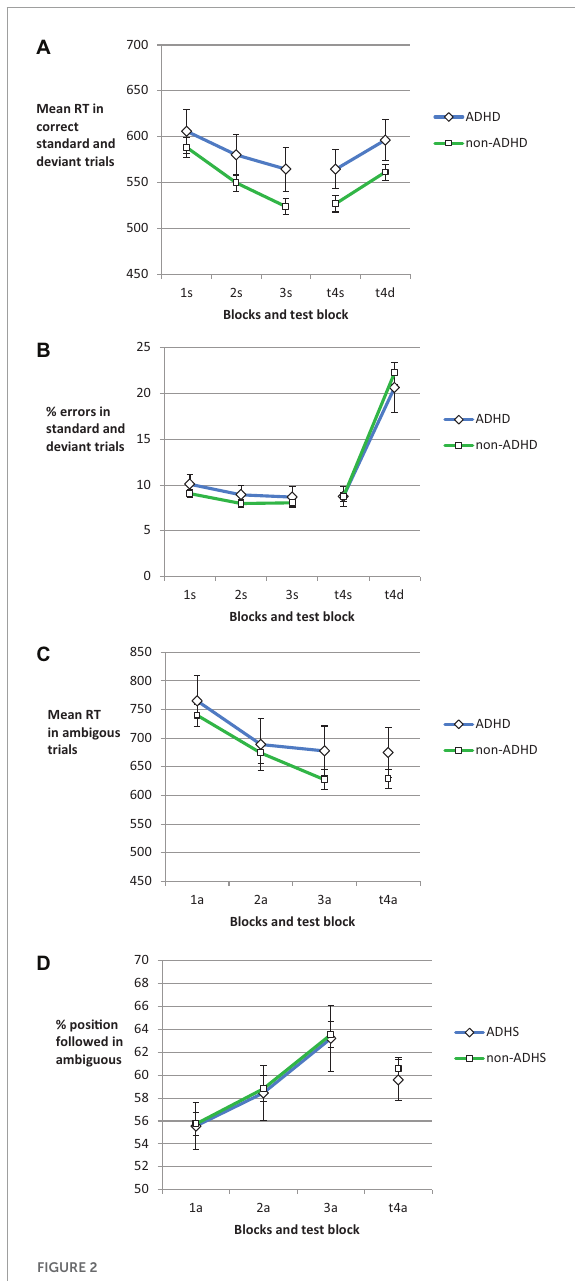
FIGURE2 Mean RT (A) and error rate (B) in standard trials for Blocks 1, 2, and 3 (practice phase), and standard and deviant trials in Block 4 (test phase). Panel (C) shows the mean RT and panel (D) shows the proportion of responses in line with the color-position covariation in color-ambiguous trials. The error bars depict the between subjects SE of the mean. On the x -axis, numbers indicate the block. Letters indicate the trial type: s, standard; d, deviant; a,